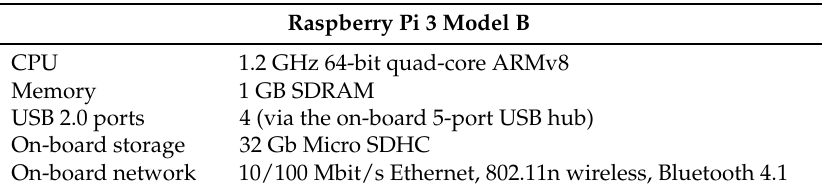
Table 1. Single-board computer